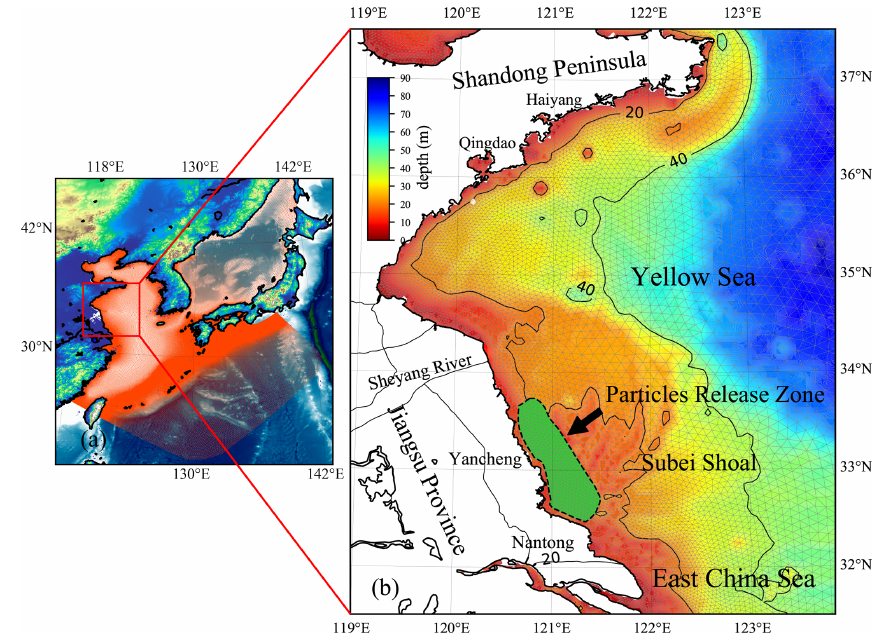
Figure 3. (a) Location of the YS, China. The red mesh indicates the high-resolution triangle grids of ECS-FVCOM. (b) The enlarged view of the area and bathymetry bounded by the solid red line rectangle in panel (a) . The green area surrounded by a black dotted line in the Subei Shoal indicates the initial release zone of simulated